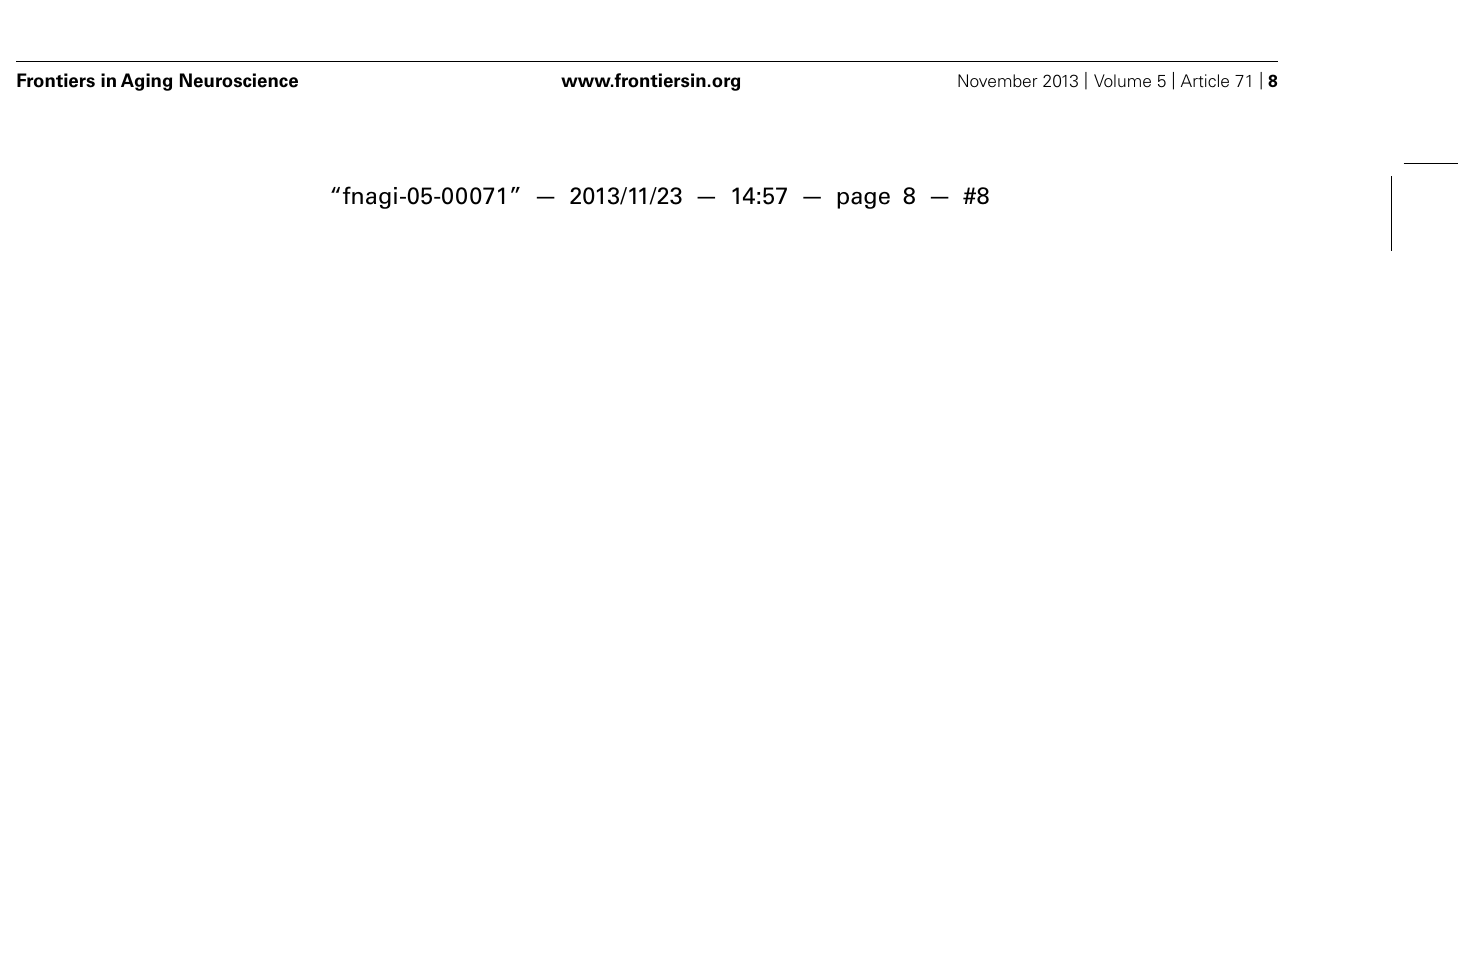
Table 1 summarizes the Pearson correlation coefficient between the mean diffusivity and age for each sex. *p < 0.05, **p < 0.01, and ***p < 0.001.